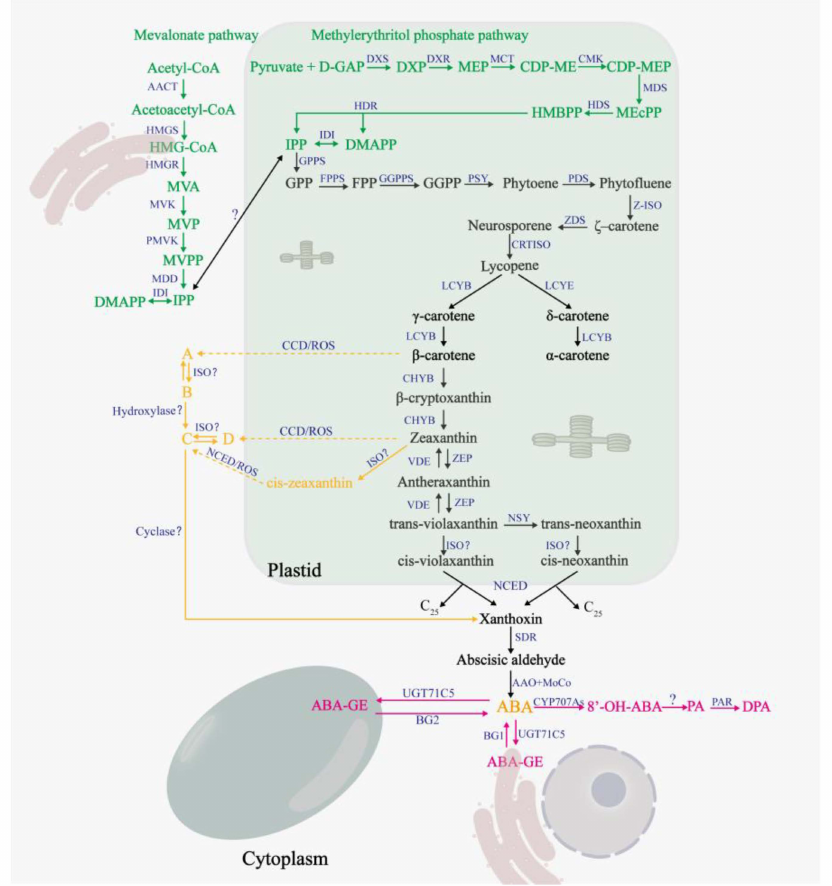
Figure 1. Biosynthesis and catabolic pathways of ABA. The mevalonate (MVA) pathway and methylerythritol phosphate (MEP) pathway are highlighted in green. The ABA synthesis path- way is shown in black, and the yellow part represents the zeaxanthin epoxidase (ZEP) -independent ABA synthesis pathway as proposed by Jia, Mi [34]. The ABA catabolic pathway and ABA cou- pling reaction are marked in red. Dashed arrows indicate multiple enzymatic steps. Enzymes are shown in blue, and unidentified enzymes are marked with question marks. Abbreviations of the enzymes or substrate that are not given in main text are as follows: (A) MVA and MEP path- way, acetyl-CoA C-acetyltransferase (AACT), HMG-CoA synthase (HMGS), HMG-CoA